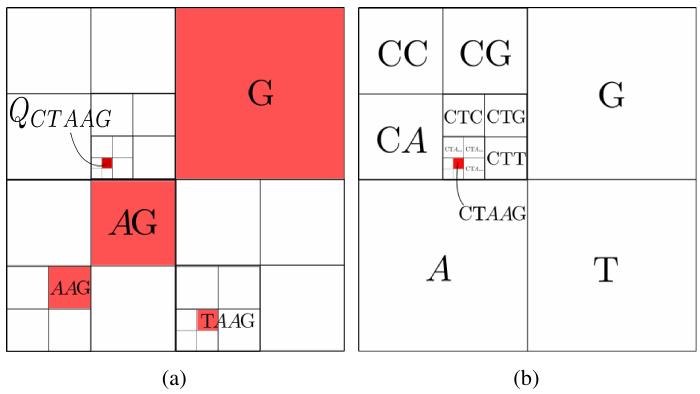
Fig. 4 Subregion’s description of GAATC , in ( a ) application of functions, in ( b )